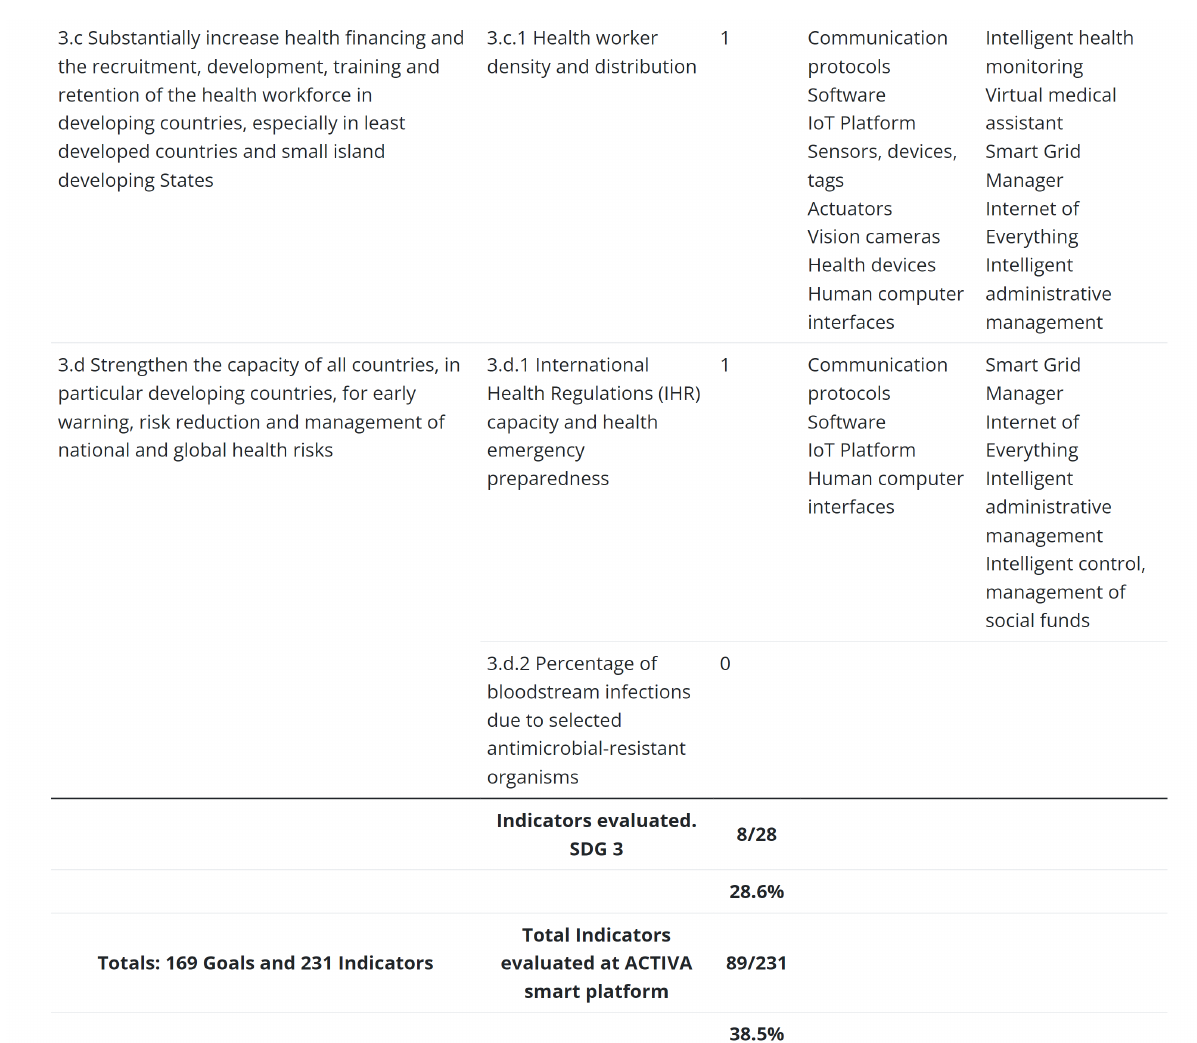
Figure 5. Website SDGs and ACTIVA platform.